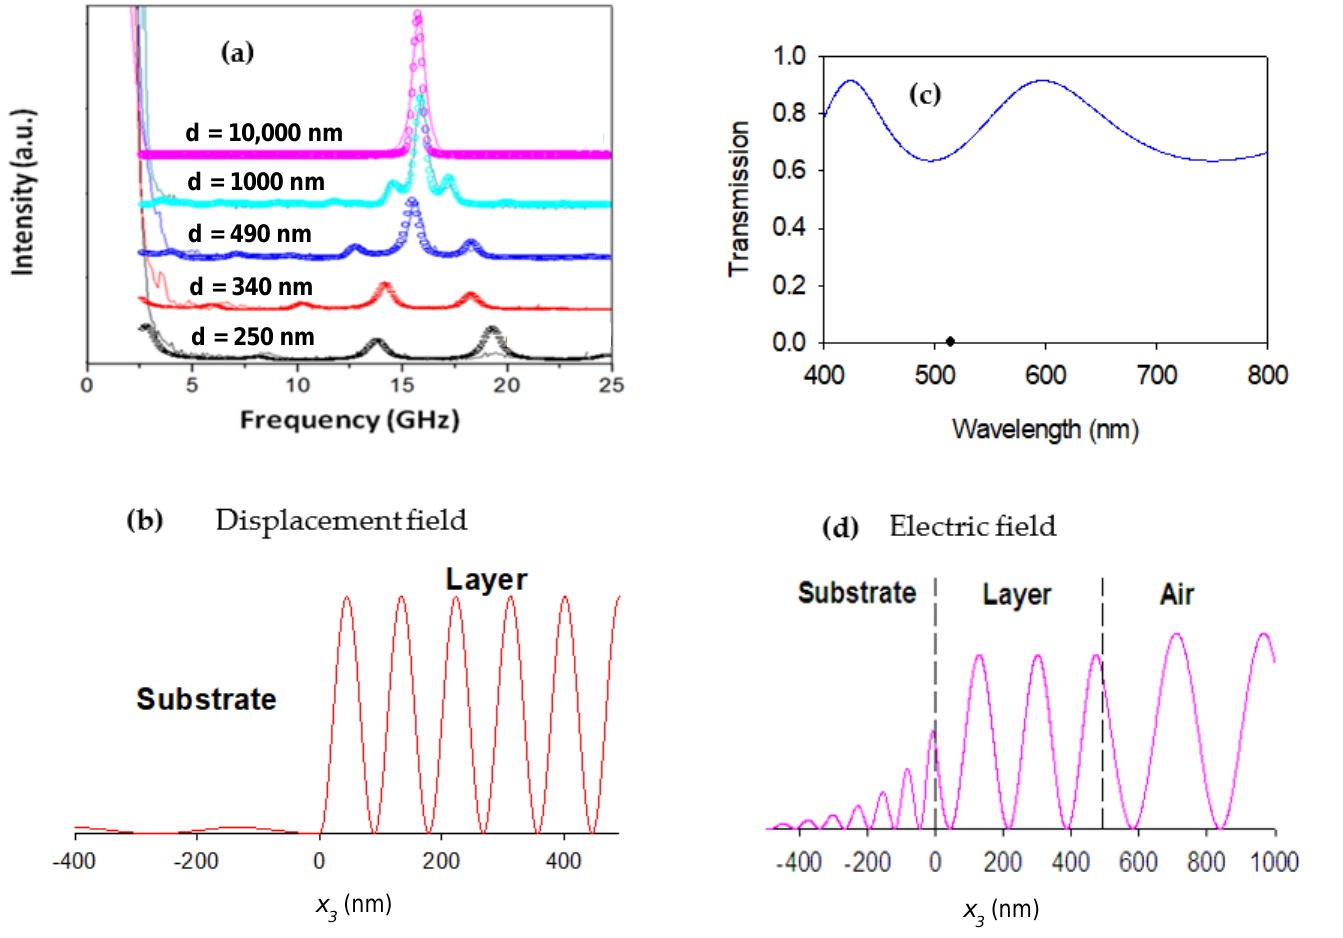
Figure 2. ( a ) Theoretical (open circles) and experimental (continuous curves) Brillouin light scattering for a series of supported PMMA films with different thicknesses deposited on a Si substrate. The main spectra appear at the frequency position of the longitudinal acoustic phonon around q = 4 π n 1 = 0.036 nm −1 i.e., 𝑓 = 𝑞𝑣 /2𝜋 = 15.9 GHz. ( b ) Square modulus of the displacement field versus the space position for the mode at f = 16 GHz and d = 490 nm. ( c ) Optical transmission through the layer versus the wavelength. The circle on the abscissa axis corresponds to 514.5 nm wavelength used in the experiment. ( d ) Square modulus of the electric field versus the space position.